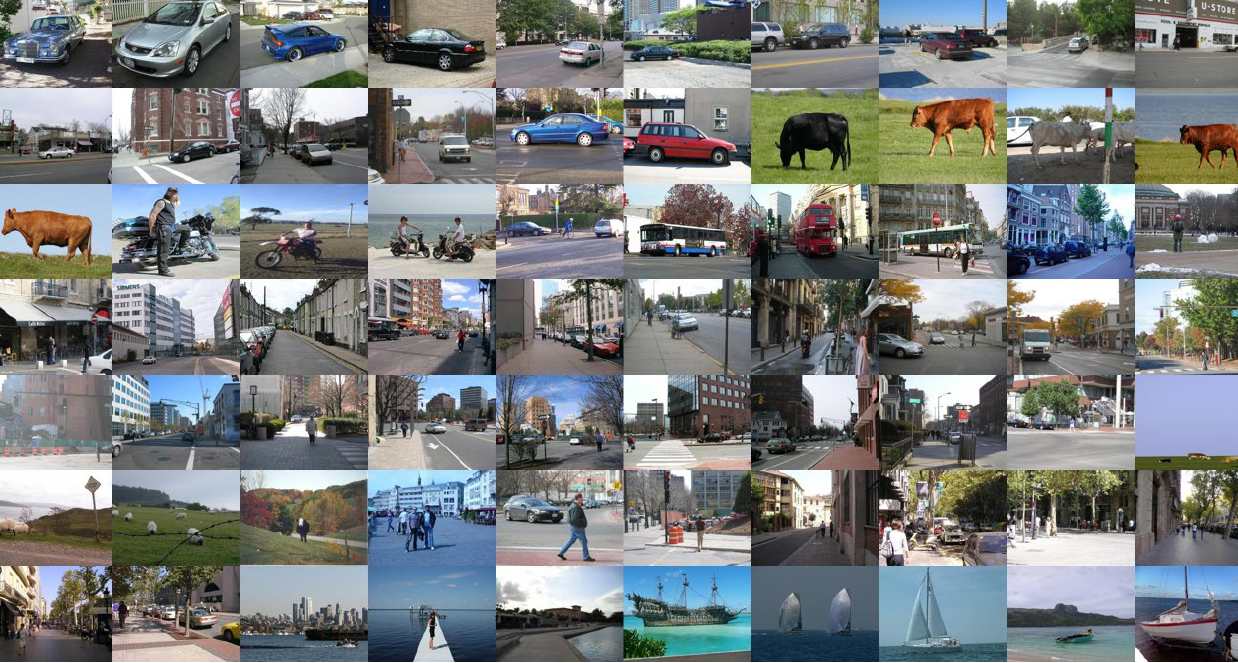
Fig. 12. A validation set of 70 images in the dataset with 9 scene categories. The dataset is of 689 images [9]. The scene categories are unequally